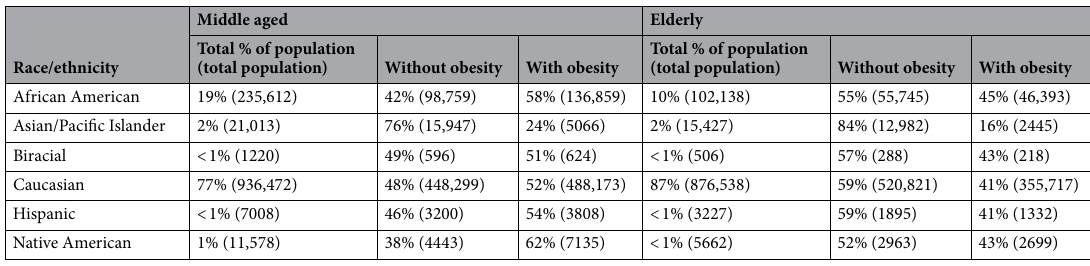
Table 1. Demographic breakdown across age and weight class.